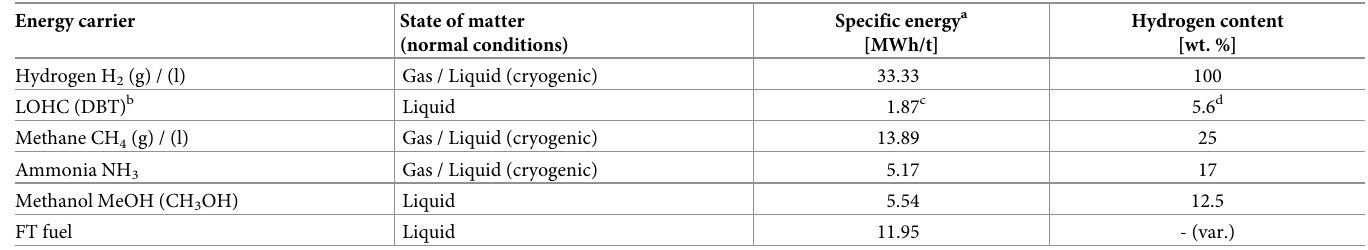
Specific energy